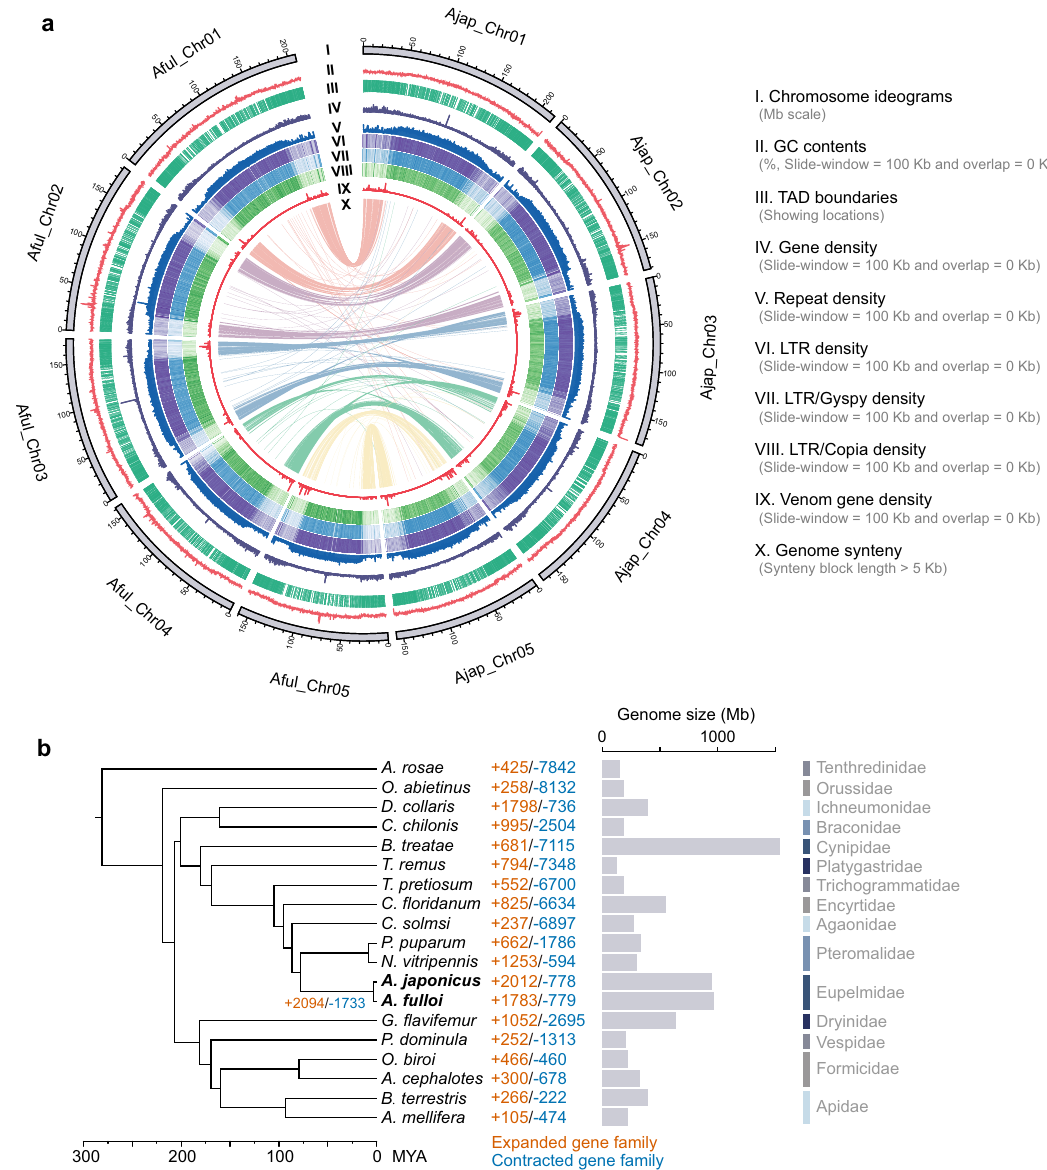
Fig.1|Genomicarchitectureofthetwo Anastatus genomesandhymenopteran phylogeny. a Genomic landscapes of A. japonicus and A. fulloi . The denotation of each track is listed on the right of the circos plot. b A maximum-likelihood phylo- genetictreeconstructedusingconcatenatedproteinsequencesof1792one-to-one orthologous genes from 19 hymenopteran species and 9 calibration points. 1000